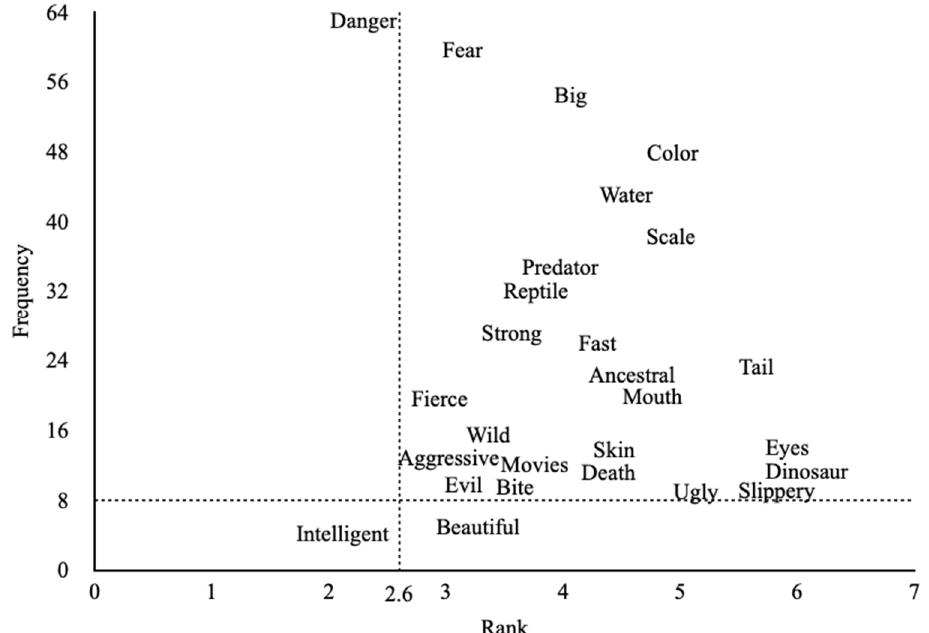
Figure 2. Scatterplot with words evoked for stimulus word “crocodile”. Cut-off points are represented by broken lines (rank = 2.6; frequency = 8). For a better read, the evoked word “teeth” is not represented due to its high frequency (114) (second quadrant).